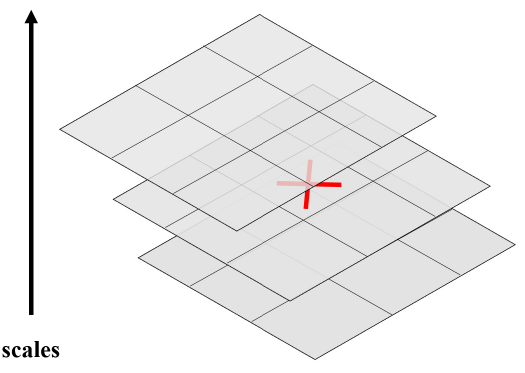
Figure 3. The 3 × 3 × 3 area where the non-maximum suppression is located.